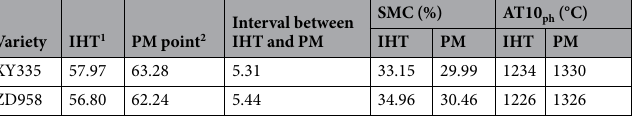
Table 4. Seed moisture content (SMC) and > 10 °C accumulated temperature from pollination to harvest (AT10 ph ) at the ideal harvest time (IHT) and physiological maturity (PM) point in XY335 and ZD958 across 8 environments. 1 IHT, the ideal harvest time, the last date to achieve maximum SG, AAG and CTG. 2 PM point, the DAP to achieve the maximum HSW